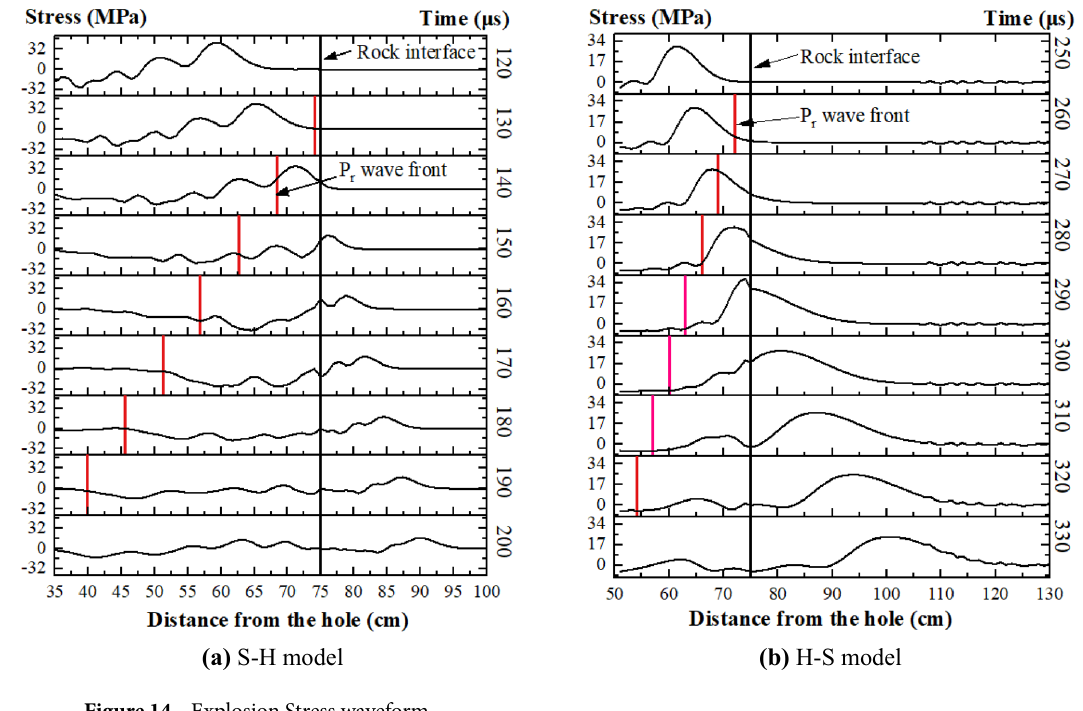
Figure 14. Explosion Stress